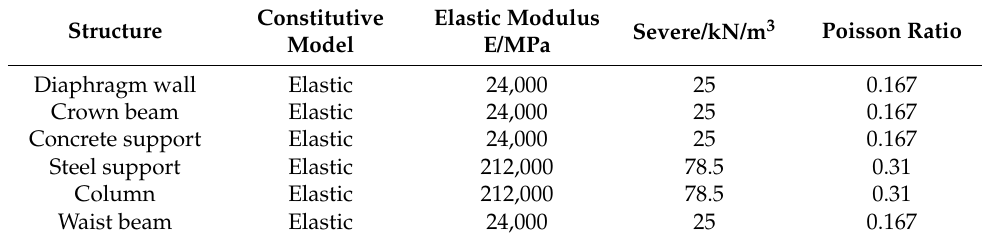
Table 5. Table of mechanical parameters of supporting structures.